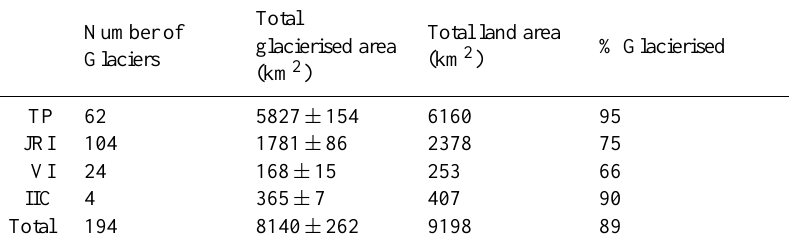
Table 3. Methods of ELA calculation. Refer to the Supplementary Methods for more information. Altitudes are derived from the 2006 SPIRIT DEM, and these ELAs are, therefore, approximations for the year 2006. Method Description Notes Represents an accumulation area ratio (AAR) of ELA MEDIAN Median Elevation 50%. Equivalent to H MEDIAN . Applied to all glaciers. Assumes an AAR of 60%; derived from hypsomet- ELA AAR Accumulation Area Ratio ric curves for the 54 tidewater glaciers over 40km 2 . Applied to 54 glaciers. Ratio between minimum and maximum glacier ELA THAR Toe to Headwall Ratio altitude. Applied to all glaciers. Transition between convex and concave contours. Hess method Applied to 69 glaciers, of which only 13 are land- terminating. Mean ELA Mean of ELA MEDIAN , ELA AAR , ELA THAR Table 4. Summary table of the glaciers of the northern Antarctic Peninsula. Uncertainty is determined by applying a 22.5m buffer to either side of the glacier polygon. TP=Trinity Peninsula. JRI=James Ross Island. VI=Vega Island. IIC=Island Ice Caps. Total Number of Total land area glacierised area % Glaciers (km 2 ) (km 2 )